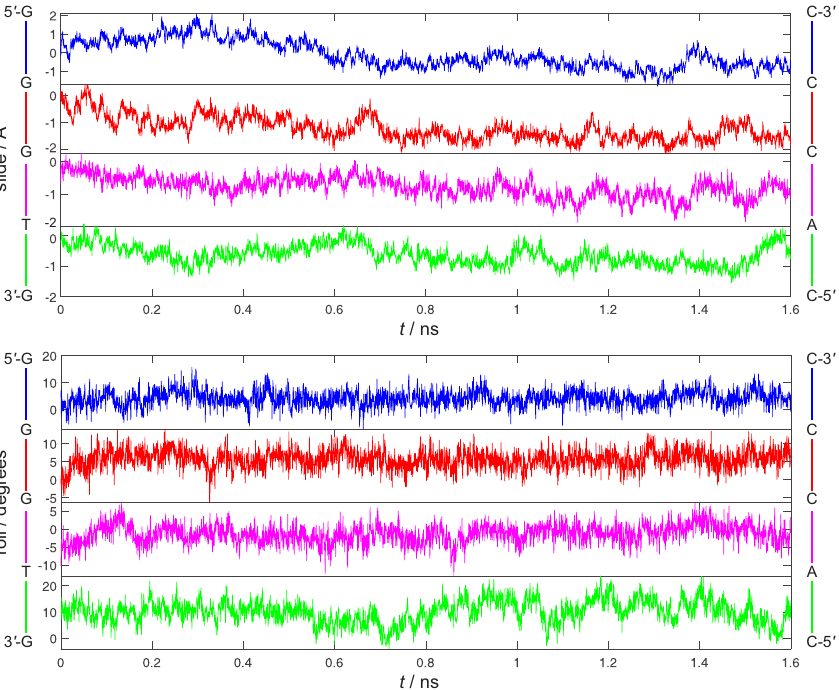
Figure 4. Time evolution of the four slide (Å, top ) and roll (degrees, bottom ) coordinates of ds-5 (cid:48) - GGGTG-3 (cid:48) during 1.6 ns dynamics simulations in water.